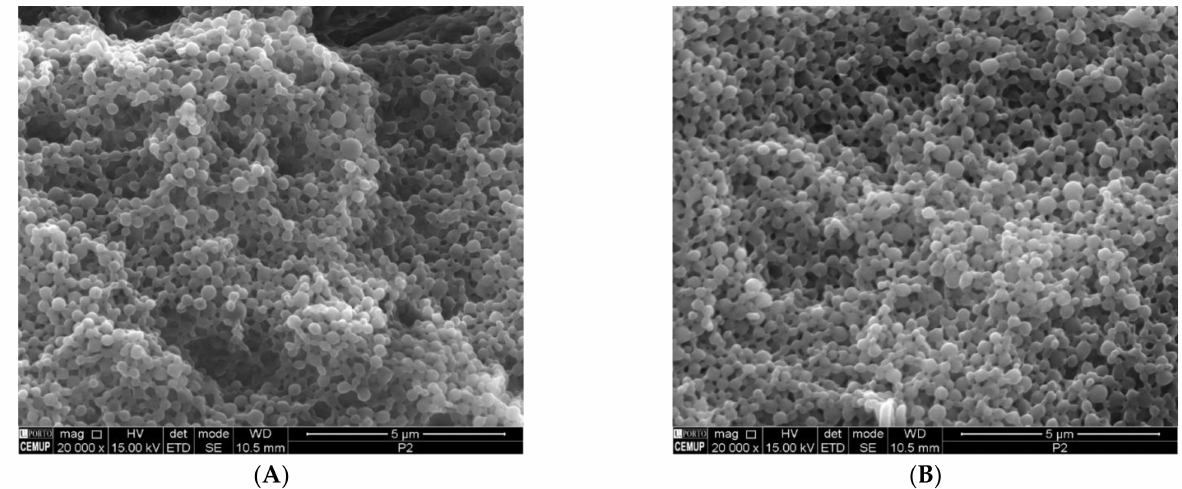
Figure 2. SEM microphotographs of unloaded nanoparticles ( A ) and XN-loaded nanoparticles ( B ) after freeze-drying (at 20,000 × ).